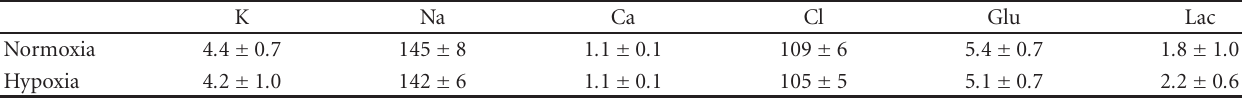
Table 2: Electrolytes, glucose, and lactate serum concentrations at baseline and under hypoxia equivalent to a height of 5500m for 2 hours. K Na Ca Cl Glu Lac Normoxia Hypoxia Values are mean ± SD, n = 14.